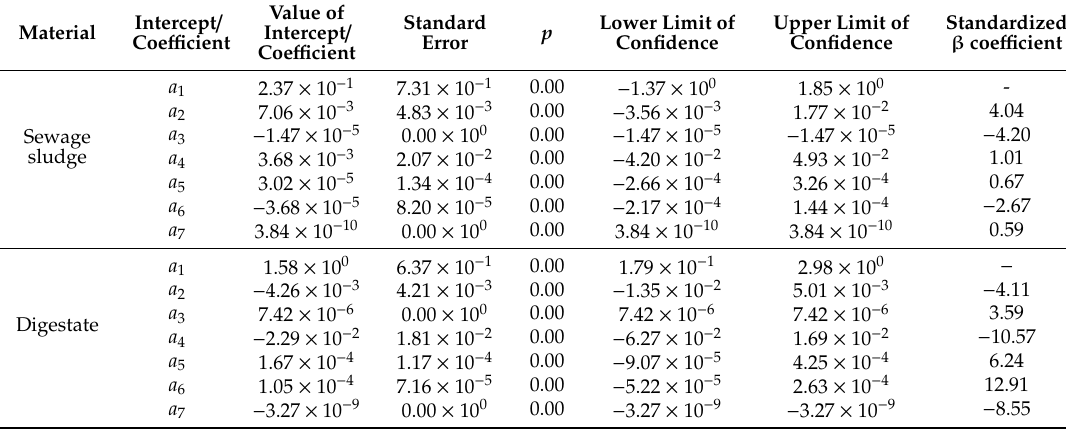
Table A2. Statistical evaluation of model coe ffi cients for the EDr of CSF from sewage sludge and digestate. Material